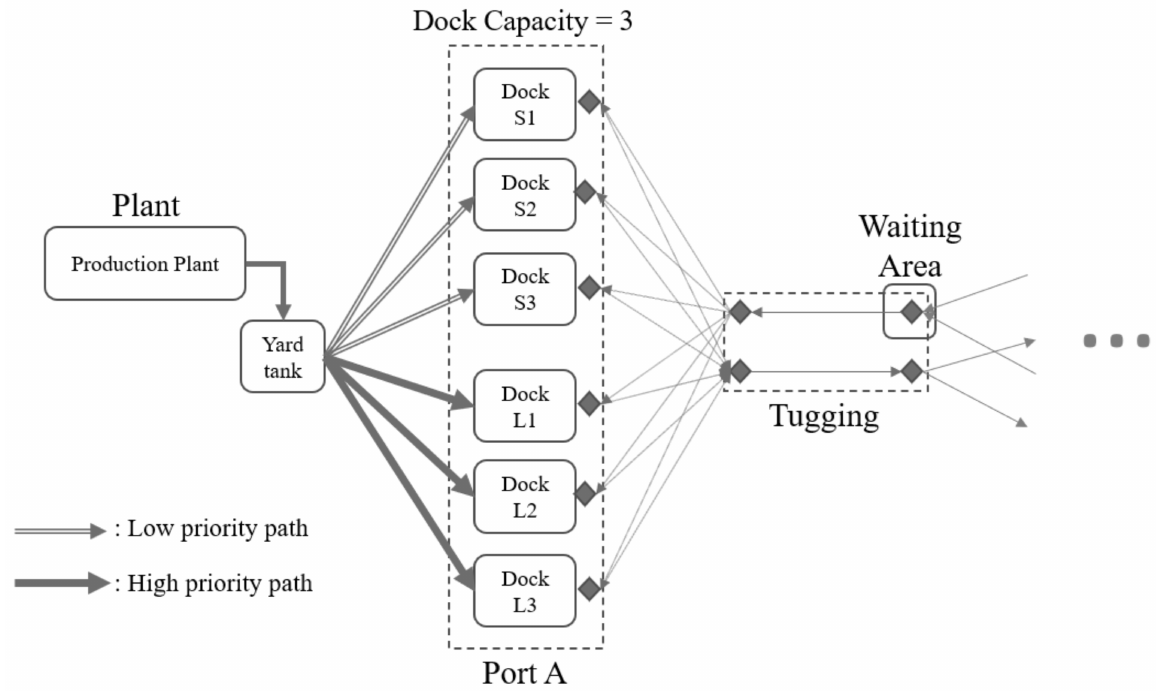
Figure 3. Simulation logic for LVFU